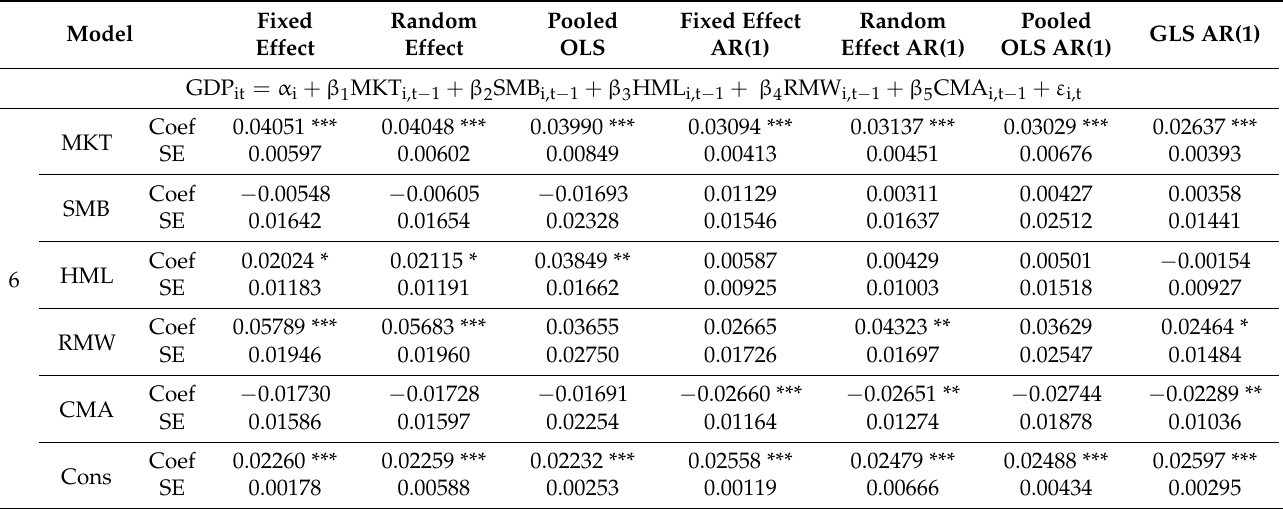
Table A2. Long-Panel Data Model Multiple Regression